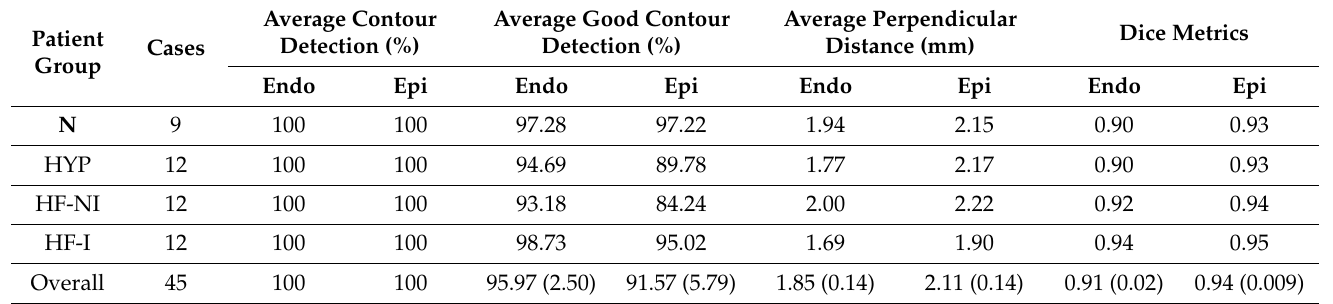
Table 15. Performance evaluation parameters for log-cosh dice loss and Elu